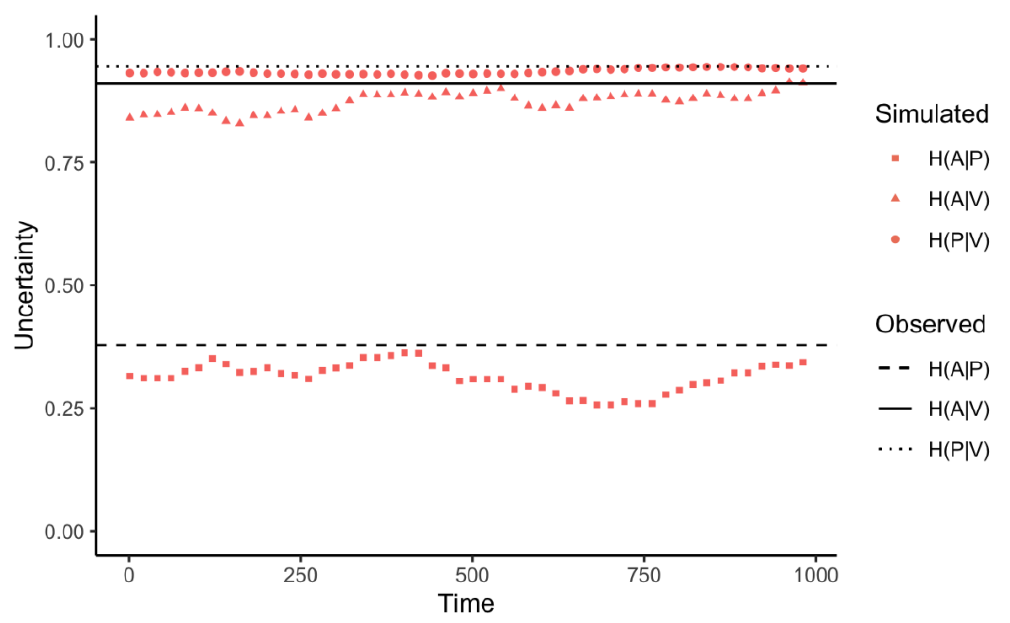
Fig. 2 Simulation of neutrally evolving plant-herbivore community, where the connectedness of the PV and AP matrices is parameterized using frequencies estimated from the field data. We estimate that plant-volatile links occur with a probability of 0.8 and plant-herbivore links occur with a probability of 0.1. Observed entropies plotted as horizontal lines are mean values from three years of data reported by Zu et al. (Compare with Figure 3A in Zu et al 2020